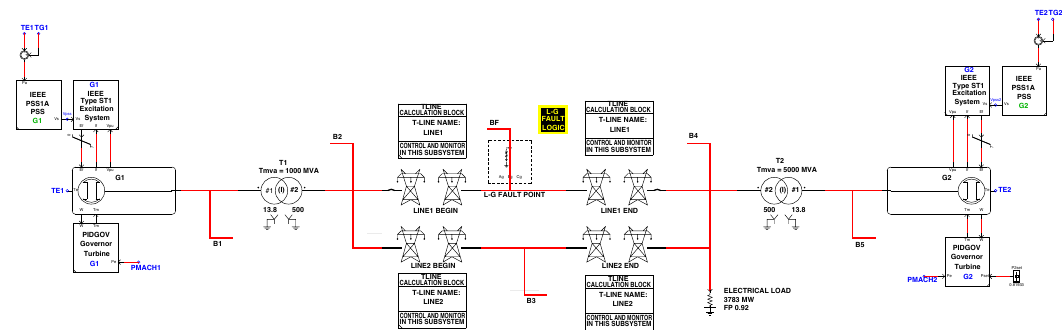
Figure 2. Implementation in RSCAD-RTDS. PSS, Power System Stabilizer. G, Generator; B, Bus.